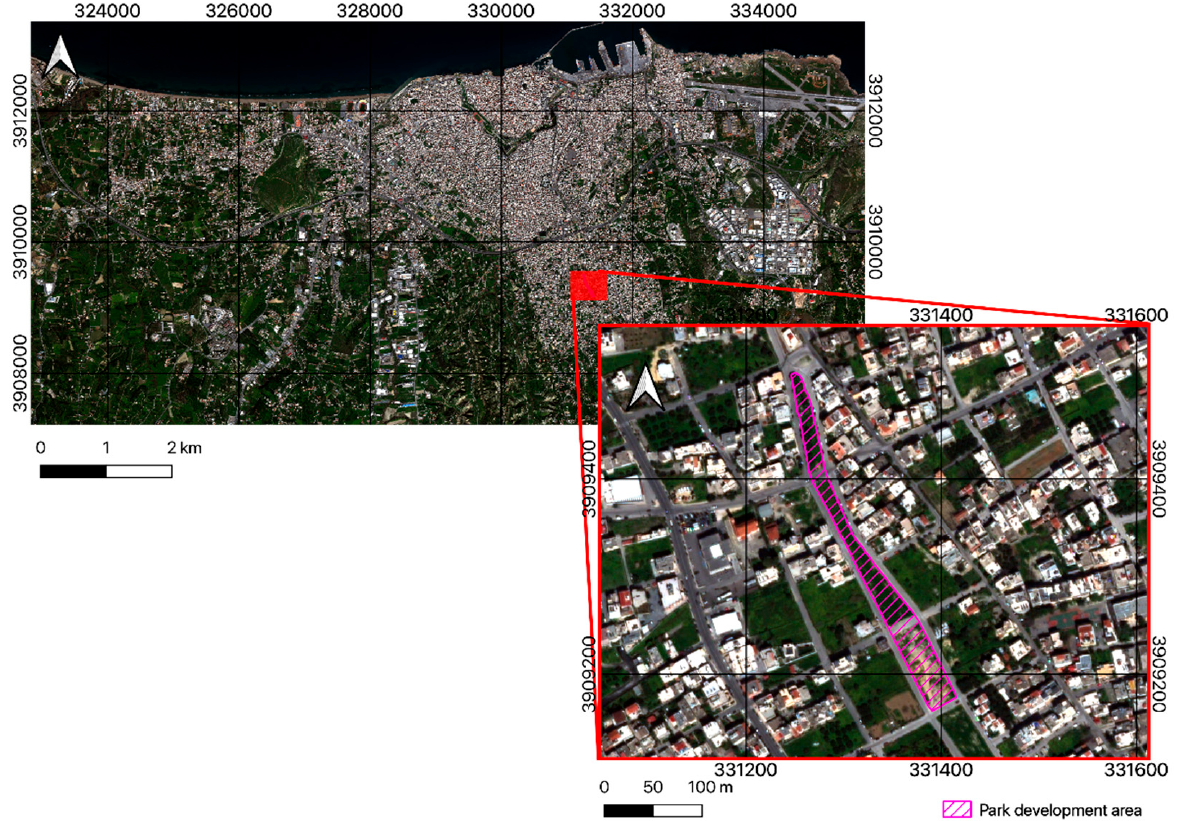
Figure 1. Map of Heraklion, Crete (background map), and area of green space development denoted within the purple polygon (zoomed map). Approximate area of polygon = 7640 m 2 .